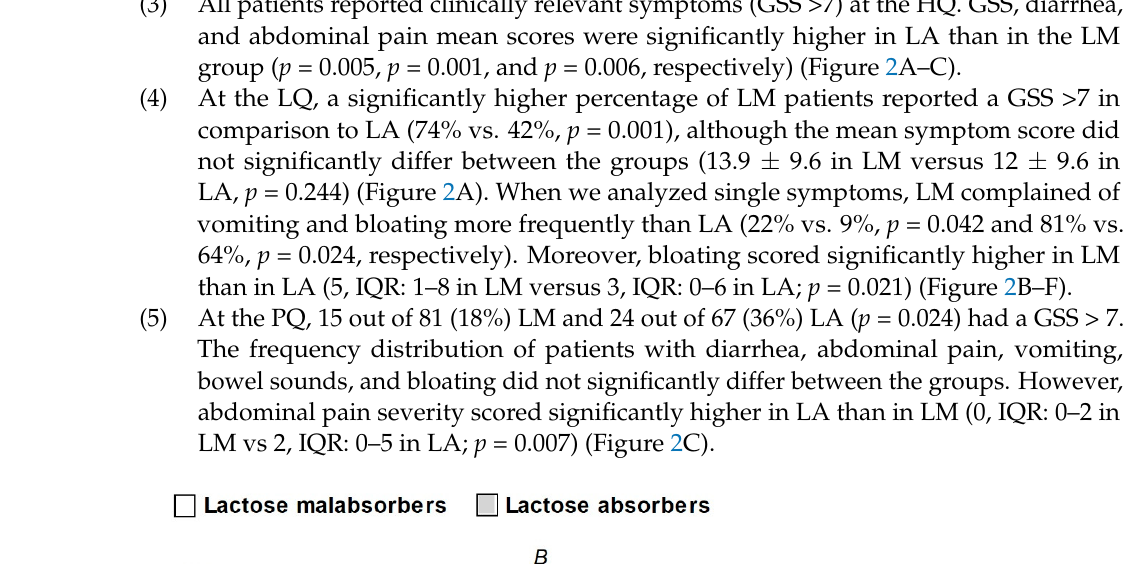
vomiting and bloating more frequently than LA (22% vs. 9%, p = 0.042 and 81% vs. than in LA (5, IQR: 1–8 in LM versus 3, IQR: 0–6 in LA; p = 0.021) (Figure 2B–F). The frequency distribution of patients with diarrhea, abdominal pain, vomiting, bowel sounds, and bloating did not significantly differ between the groups. However, abdominal pain severity scored significantly higher in LA than in LM (0, IQR: 0–2 in LM vs 2, IQR: 0–5 in LA; p = 0.007) (Figure 2C).